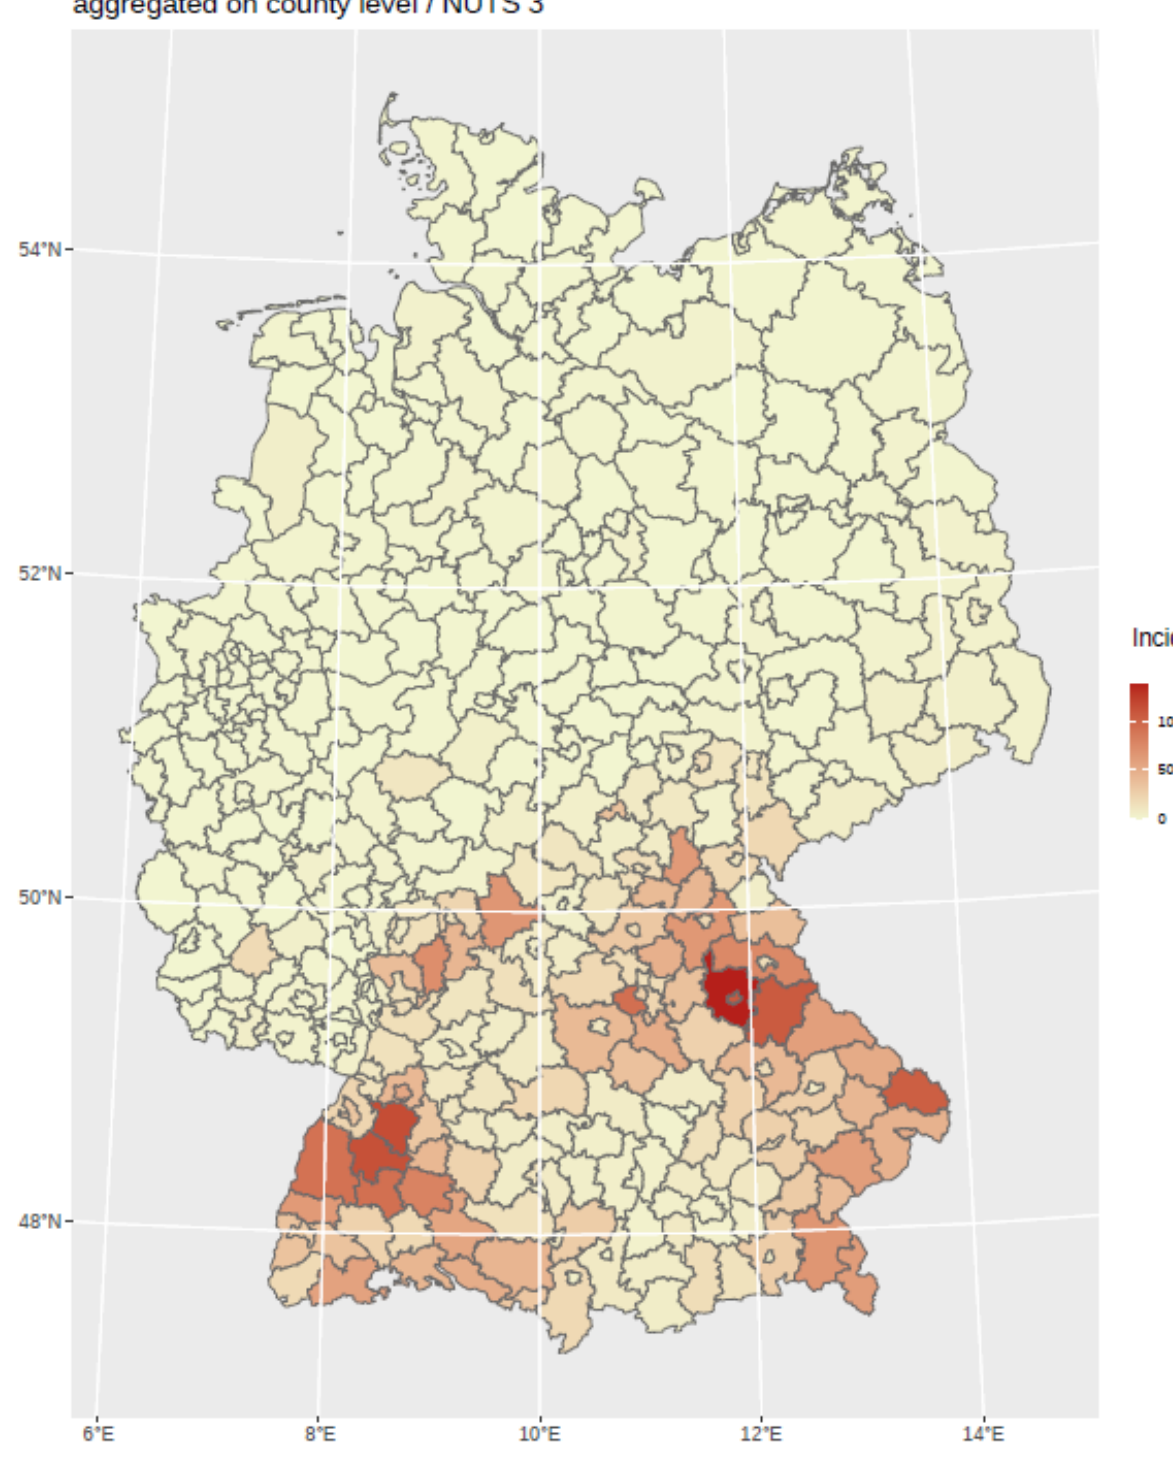
Figure 7. TBE incidence between 2001 and 2020 in Germany based on notified TBEV infections, aggregated on NUTS 3 level. The incidence is displayed in different red shades.